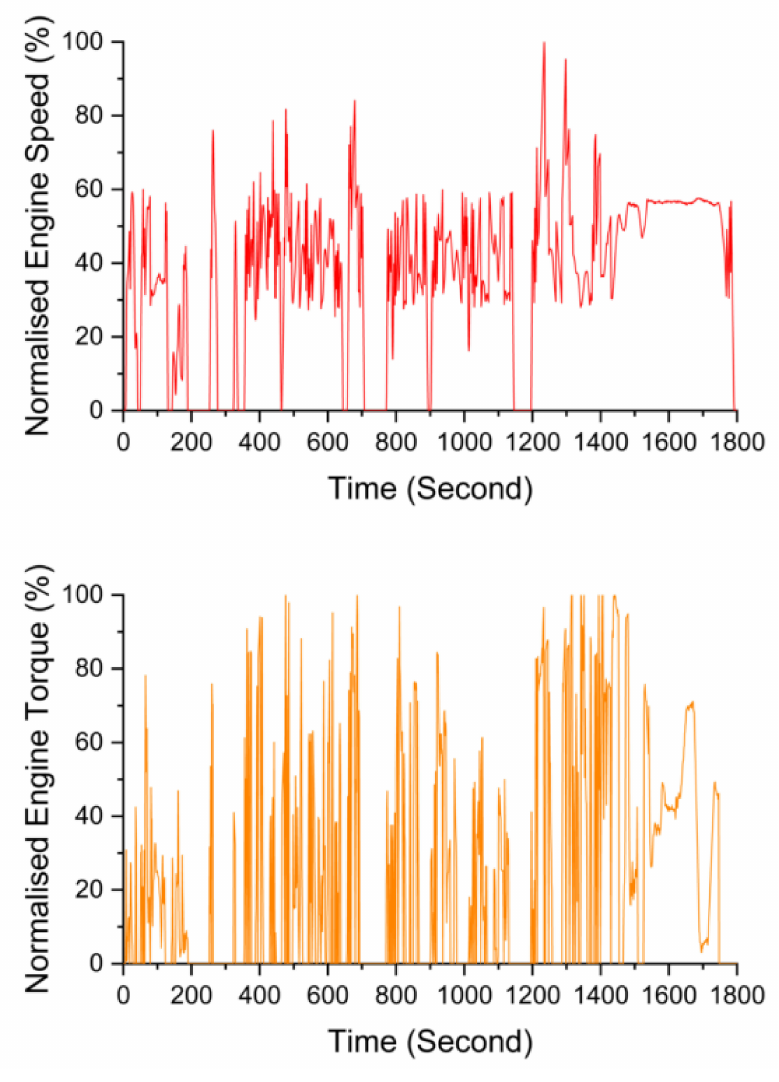
Figure 17. Engine speed and torque profile of the WHTC transient